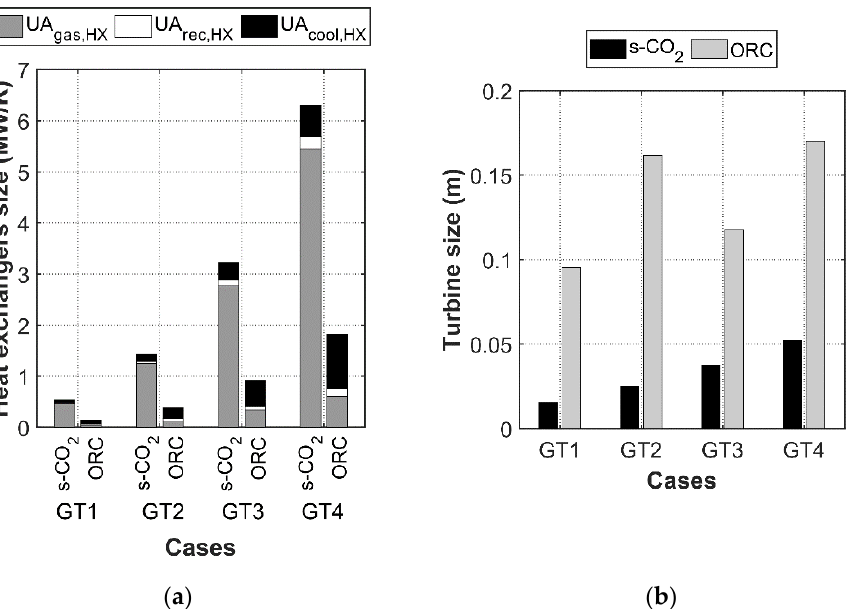
Figure 10. Component size: ( a ) turbine size parameter; ( b ) heat exchangers’ global heat transfer coefficients.